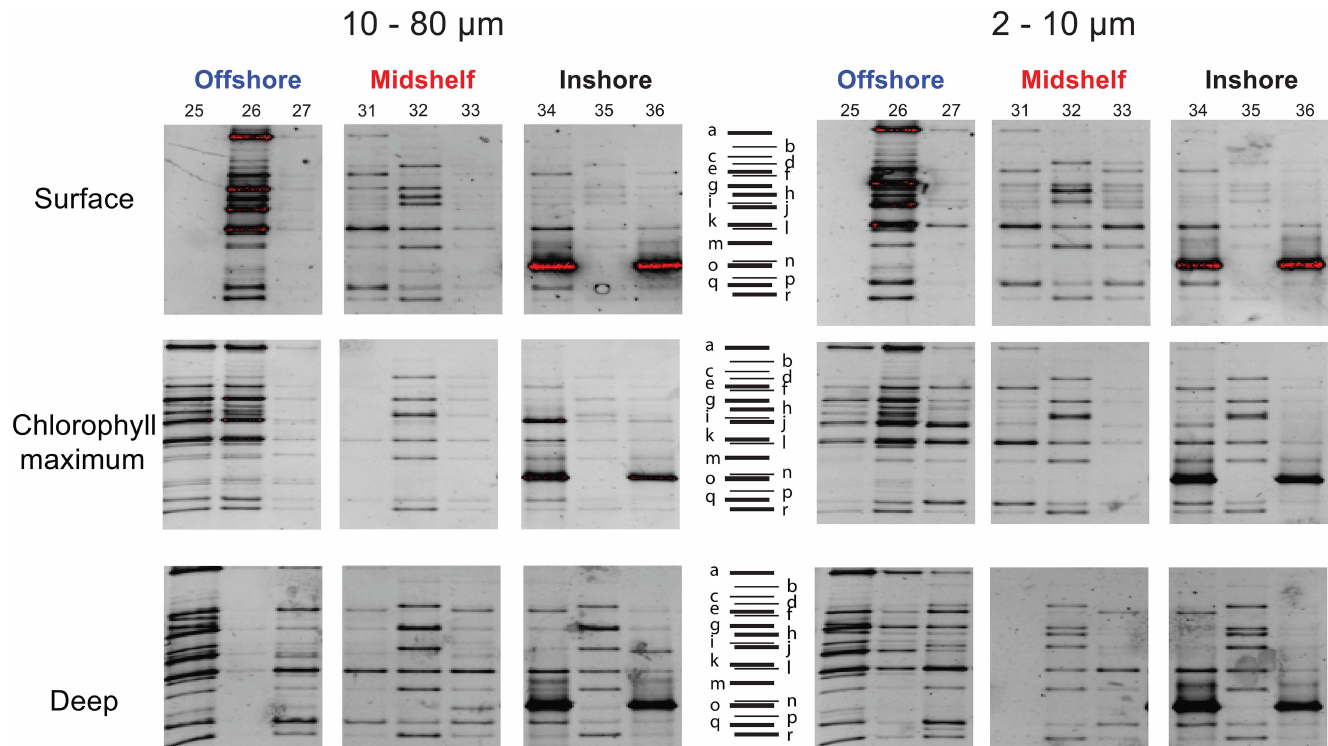
Fig 3. Analysesof common community membersby DGGE reveal a more diverse community offshore at every depth, and patchiness for the midshore and inshore stations. The middle station of the inshore and midshore has a different community of abundanttaxa as compareto the two other stations. A bloom by one OTU is evidenceby DGGE at stations 34 and 36. Empty lanes represent samples that failedto PCR, likely due to either presence of PCR inhibitorsin the water column or the absenceof target community